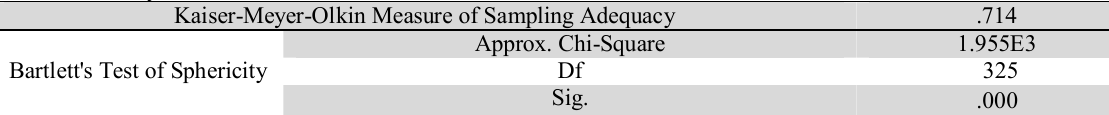
The summary of KMO and Bartlett’s